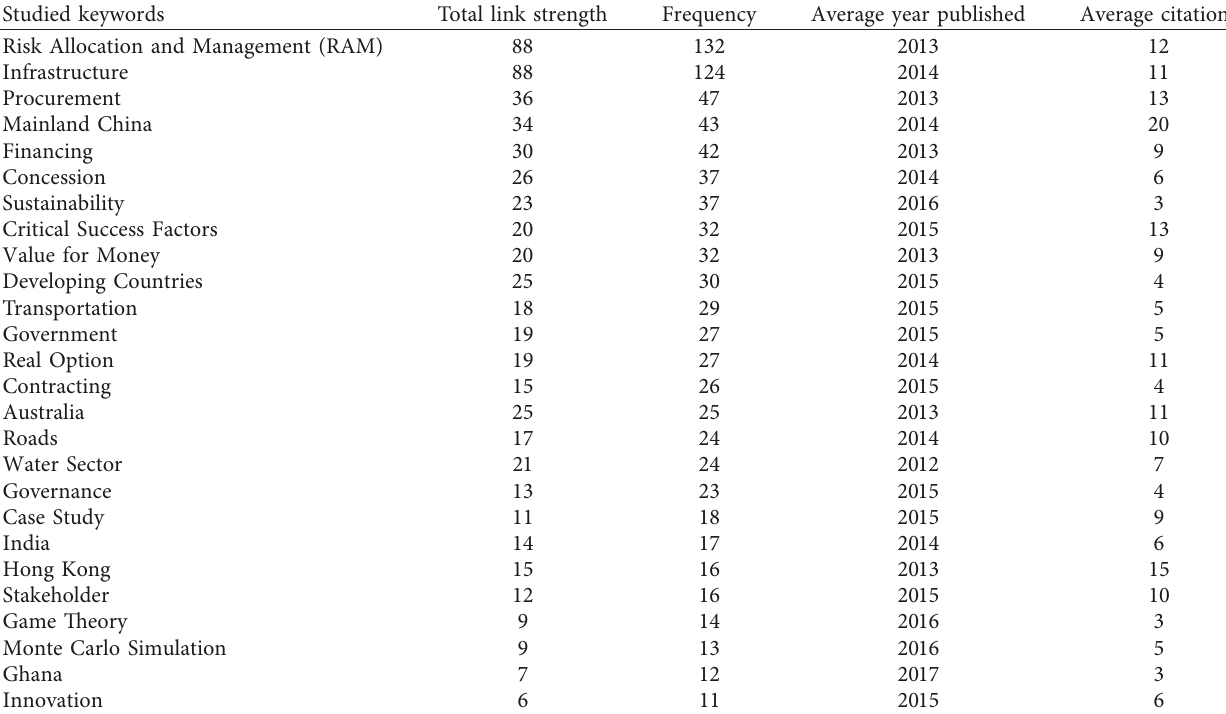
Table 2: Summaries of most frequently studied keywords in PPP. Studied